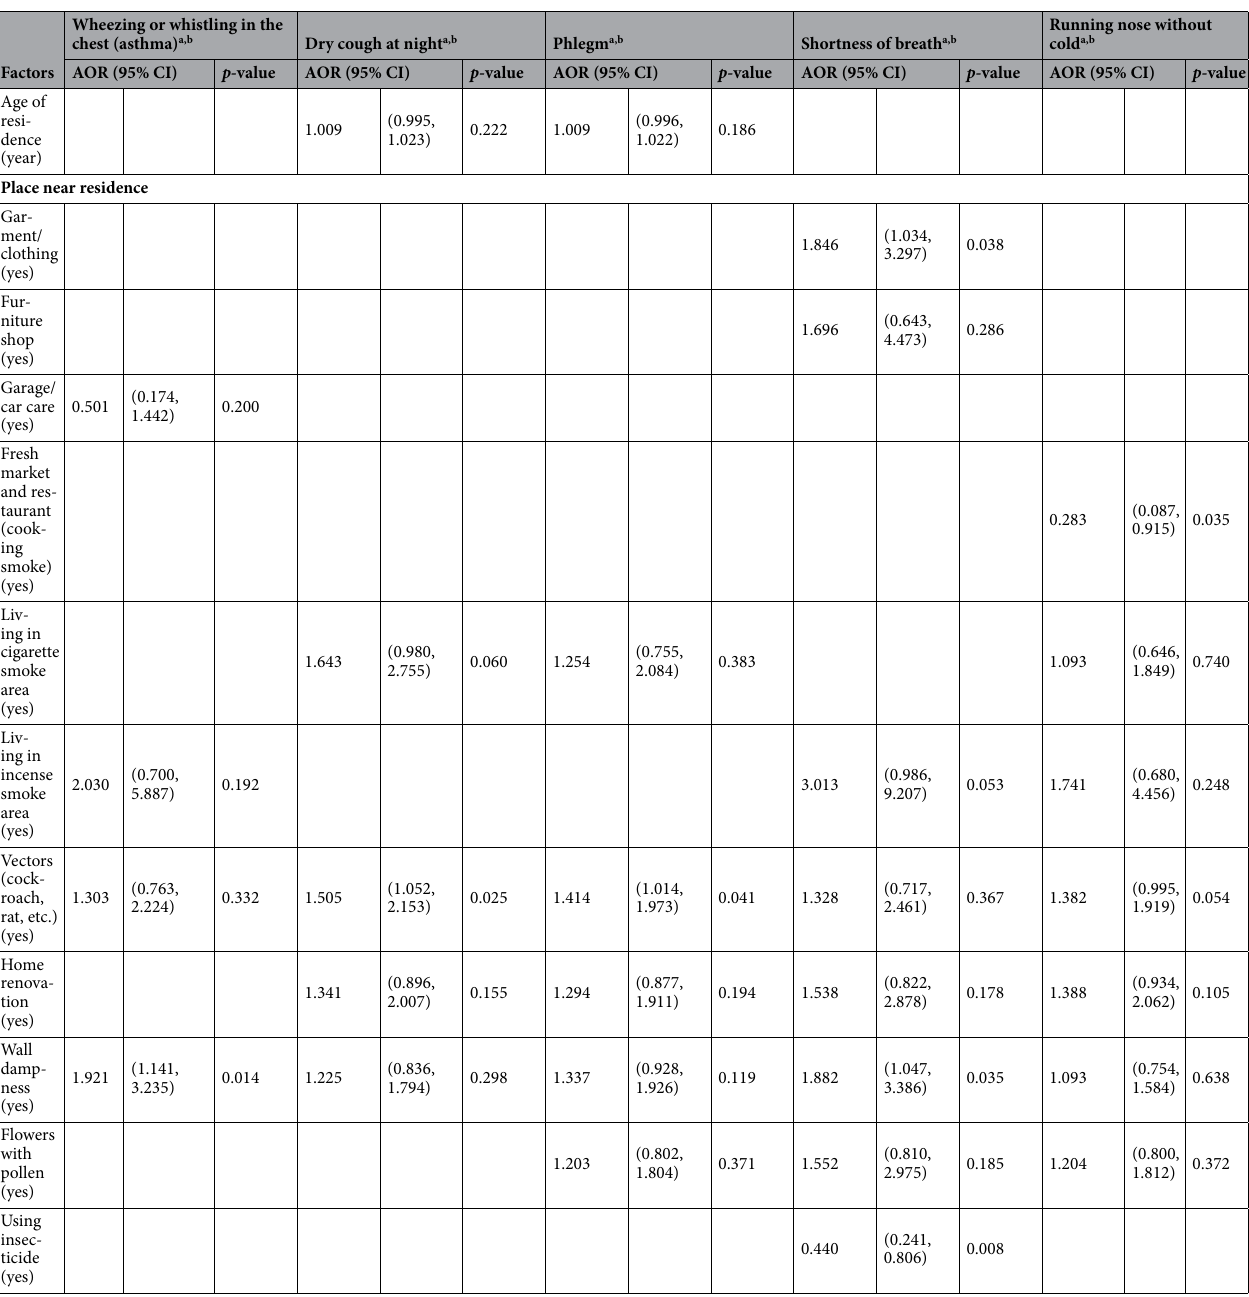
Table 3. Binary logistic regression model of associations between residential environment and respiratory/ asthma symptoms (n = 658). a All models were adjusted for age of children, children gender